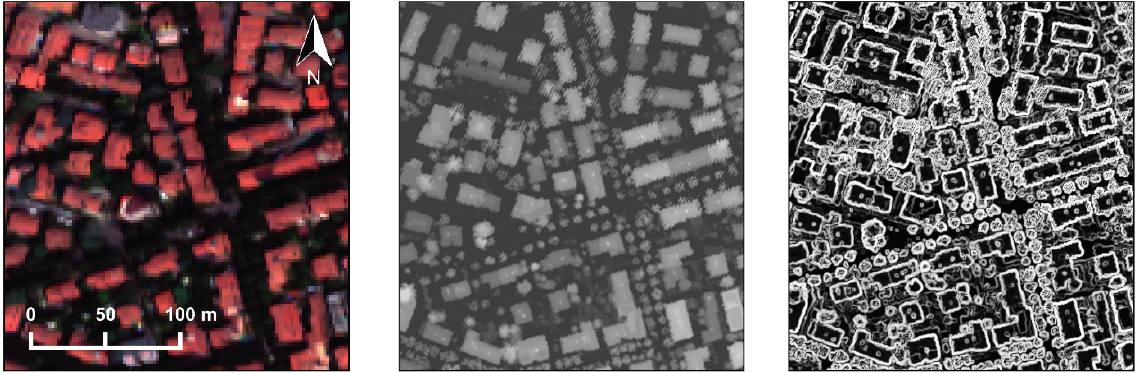
Figure 4. On the left, an RGB color composite of the WorldView-2 image; in the middle, a grey-scale visualization of the DSM; on the right, a visualization of the slope layer derived by the